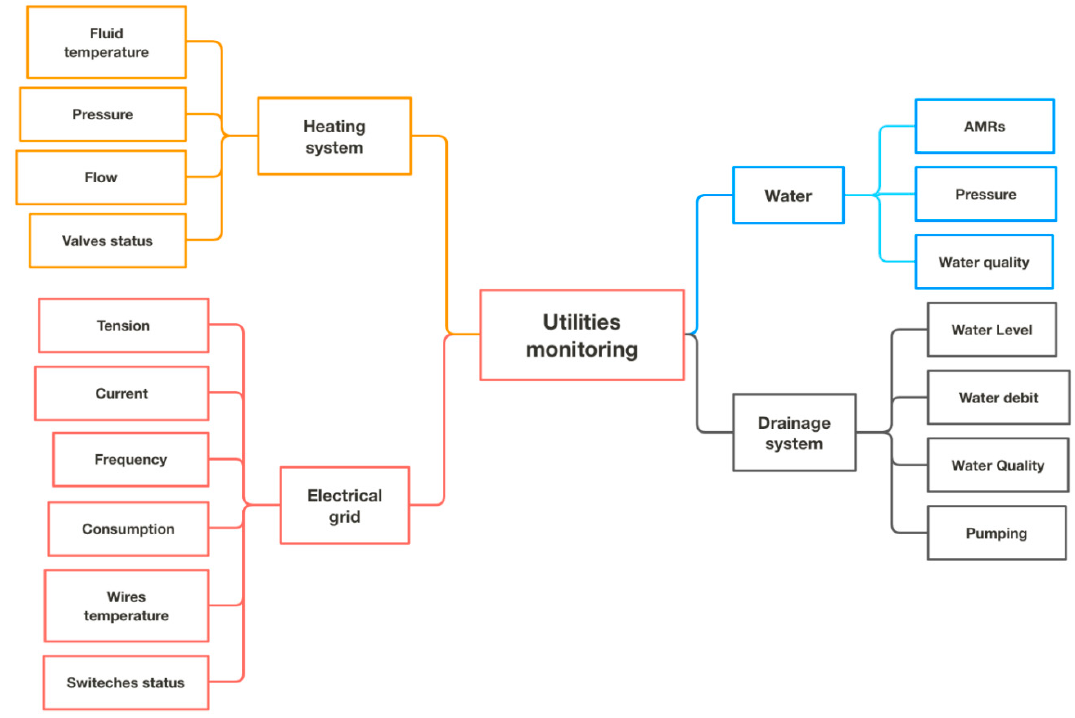
Figure 6. Main utilities monitoring.